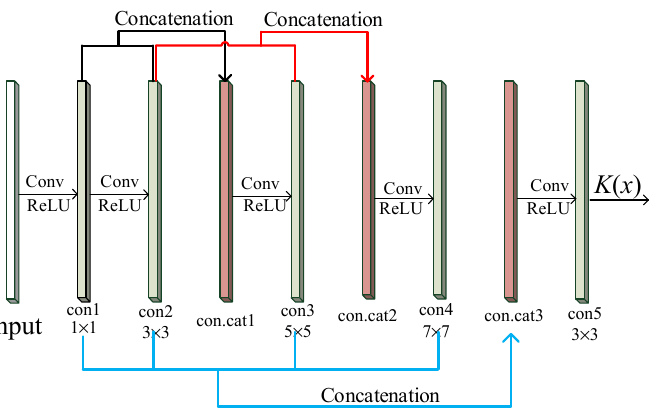
Figure 6. Framework of CNN structure for K ( x ).